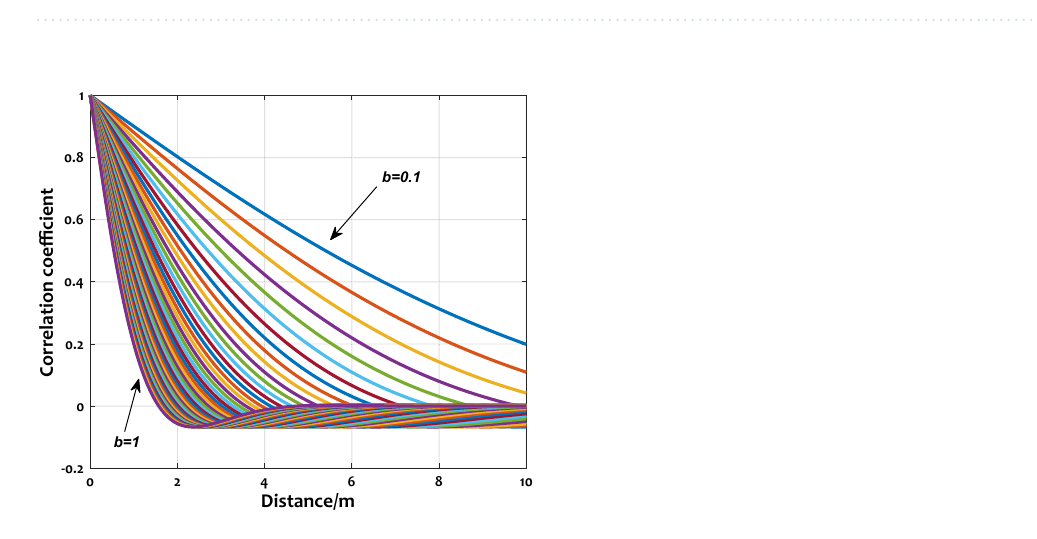
Table 3. Comparison of first-order and second-order accuracy displacement expectation.